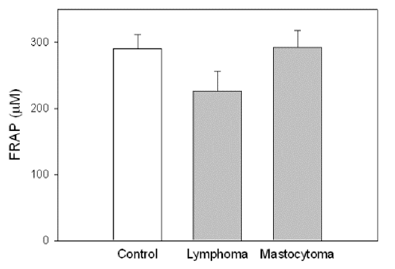
Figure 5. Ferric reducing-antioxidant power (FRAP) levels expressed as µM. Healthy dogs (control, n = 24), multicentric lymphoma (lymphoma, n = 11), primary cutaneous MCT (mastocytoma, n = 14).